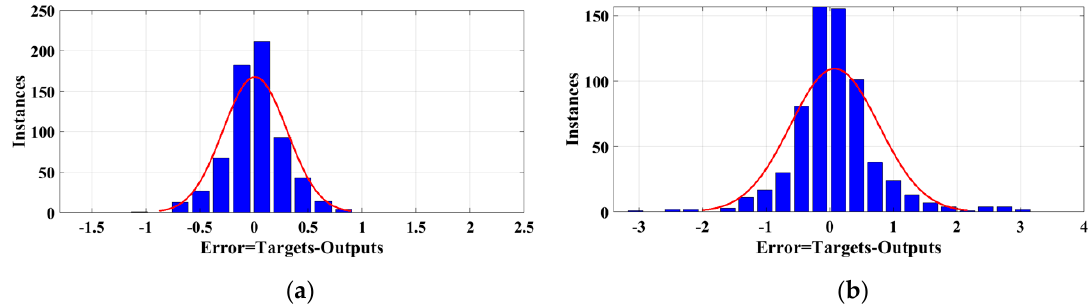
Figure 5. MLP testing error in the for histogram; ( a ) heating load; ( b ) cooling load.